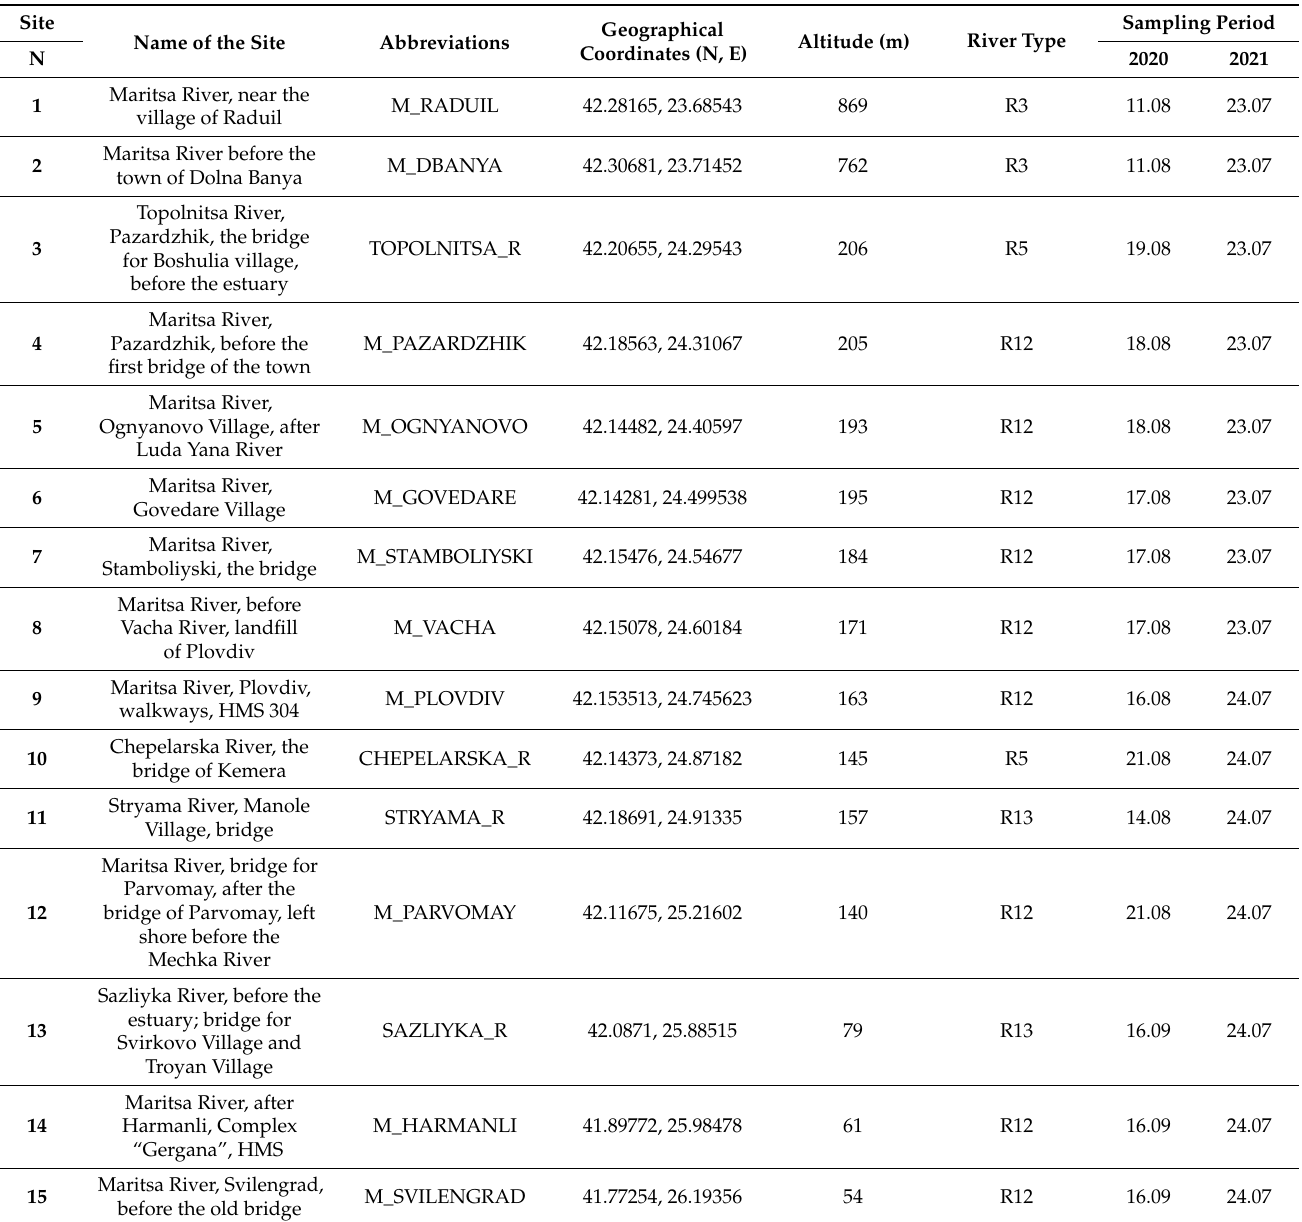
Table 1. Names and characteristics of the sampling